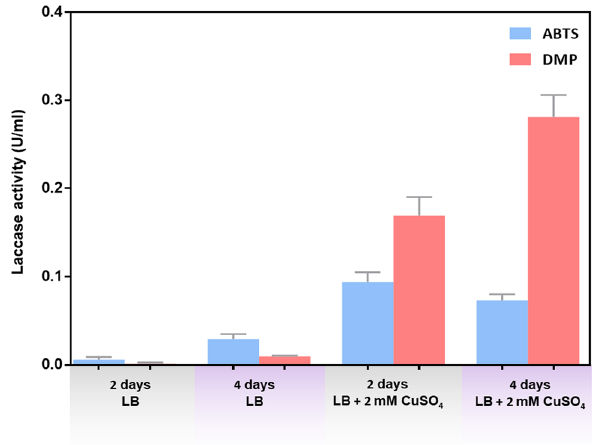
Figure 1. Effect of CuSO 4 and incubation time on laccase production. The bacteria were grown in Luria– Bertani (LB) broth with and without 2 mM CuSO 4 and incubated at room temperature for 2 and 4 days. The crude laccase activity from NI-65 was determined using ABTS (blue bar) and 2,6-DMP (red bar) as substrates. Values are means ± standard deviations of triplicate assays.